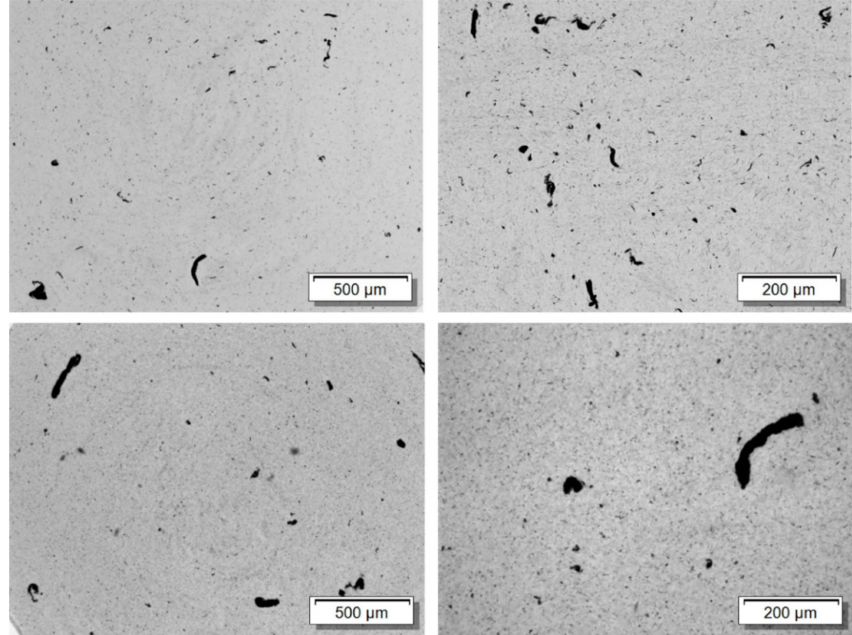
Figure 6. Transmission light microscopy images on thin sections of PP / 1 wt% B-SWCNT ( top ) and PP / 1 wt% SWCNT ( bottom ) composites (section thickness 5 µ m).